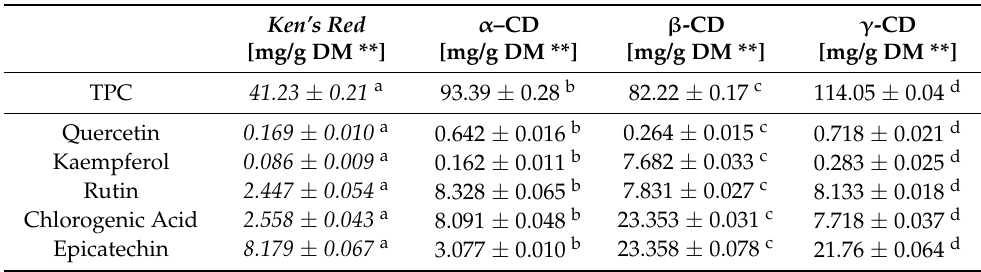
Table 3. Quantitative analysis of the contents of active compounds in extracts obtained using selected cyclodextrins.